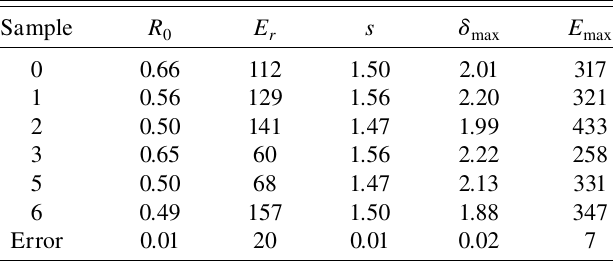
TABLE II. Fitted secondary yield parameters for TiN curves in Fig. 5. The asymptotic reflection probability was set (cid:15) 0 . The last row gives typical errors for the least to R inf squares fits.